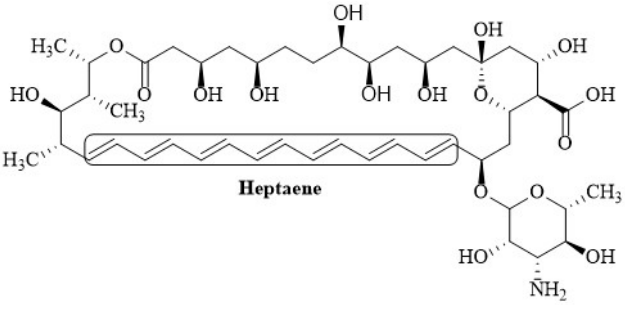
Figure 3. Structure of Amphotericin B 1 .